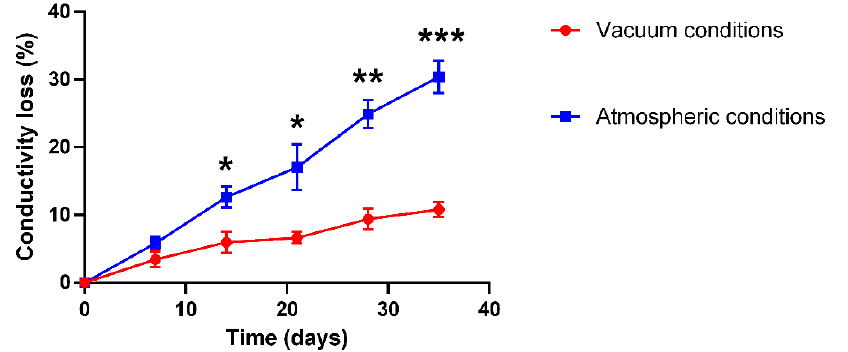
Figure 1. Conductivity loss of PLA-PPy microfibers stored under vacuum conditions and under atmospheric conditions for 35 days. The samples stored under atmospheric conditions suffered a higher conductivity loss than the samples stored under vacuum conditions. Statistically significant differences are indicated by *, ** or ***, indicating a p -value below 0.05, 0.01 or 0.001, respectively.